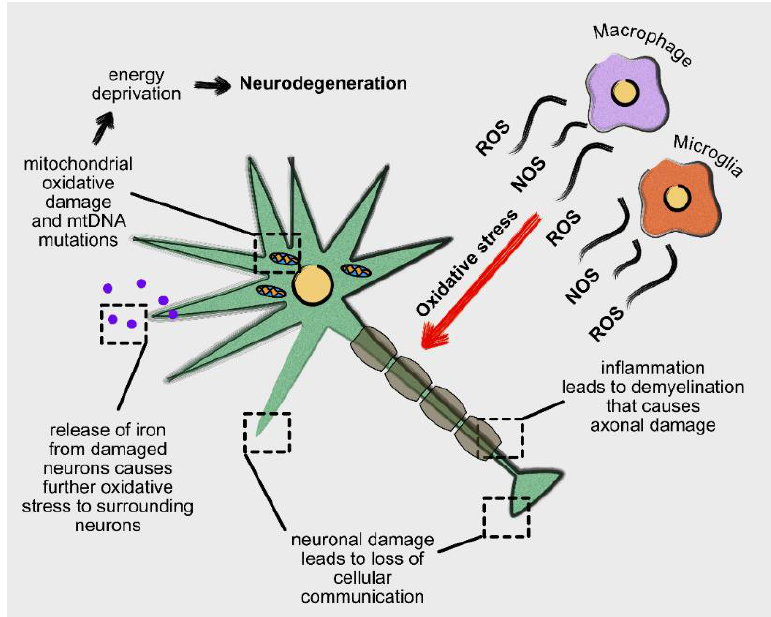
Figure 2. The interplay between neuroinflammation and neurodegeneration. Reactive microglia and infiltration of the nervous system by the peripheral immune cells may cause inflammation. Neuroinflammation may lead to oxidative stress, axonal damage, loss of cellular communication, mitochondrial dysfunction and eventually, may contribute to neurodegeneration.